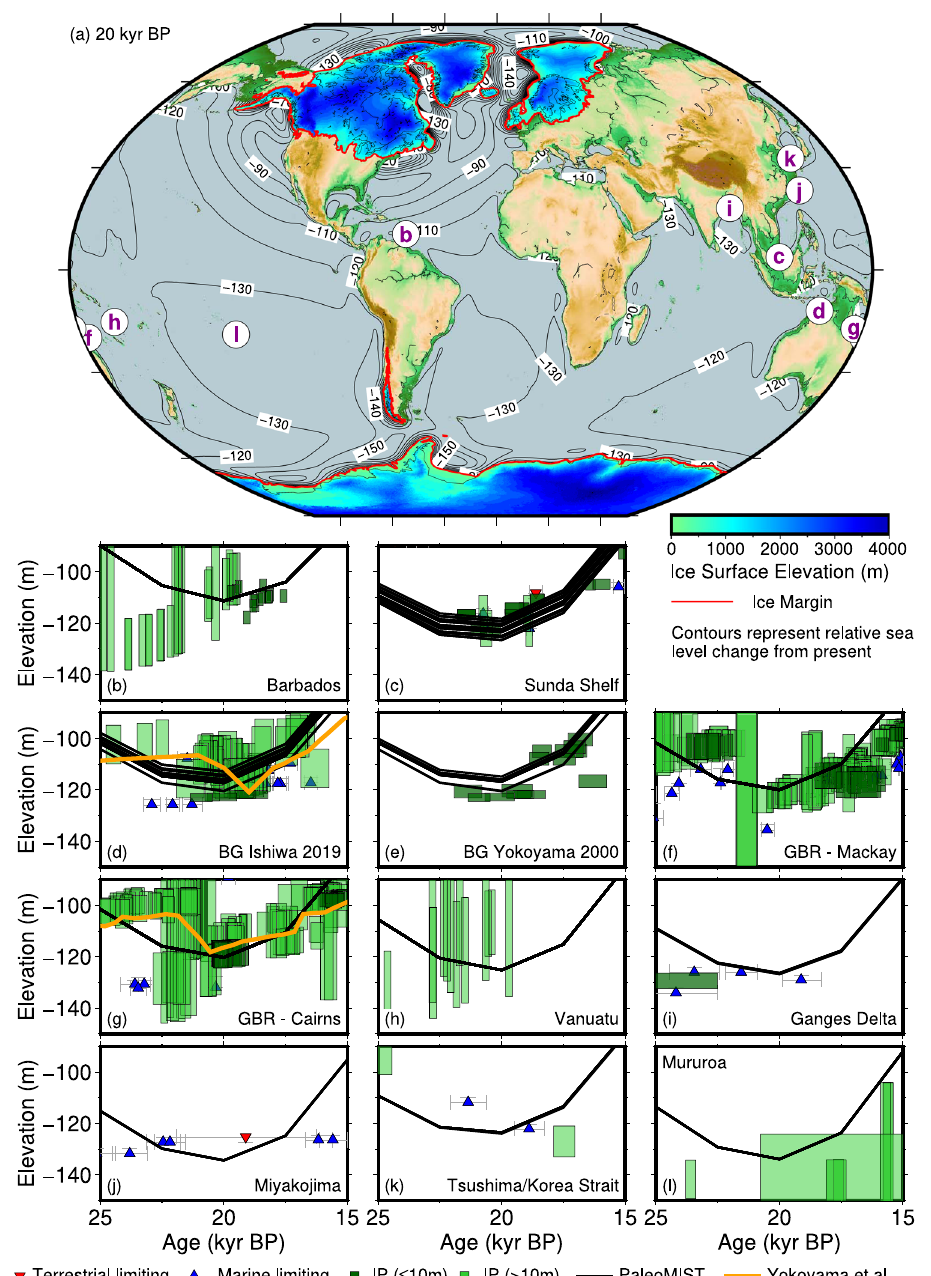
Fig. 1 | Last Glacial Maximum paleotopography reconstruction from Paleo- MIST,andfar- fi eldrelativesealevelproxies. Theminimumsealevelinthismodel happens at 20kyr BP (thousands of years before present). Since we calculate sea levelatthelocationofeachobservation,insomelocationsthereisarangeofvalues if thereisaregionalgradient.The orangelinesrepresentthe sealevelcurves inthe comment by Yokoyama et al. Index points (IP) have been separated based on whether the water depth range uncertainty is below or above 10m. Error ranges